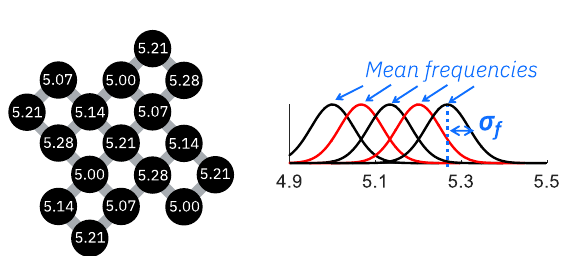
Fig. 6 Frequency collision statistical model. Left: Square lattice, d = 3 with 5-frequency pattern of Fig. 3: f 1 = 5.00, f 2 = 5.07, f 3 = 5.14, f 4 = 5.21, f 5 = 5.28 GHz. To model the lattice statistically, treat the frequencies f 1 to f 5 as means of distributions. Right: Mean frequencies and normal distributions characterized by σ f . For each position in the lattice, sample from the local distribution. Choose random frequencies in this fashion, count collisions as described in Table 1, and repeat to gather statistical sample. Process is repeated for differing spacings between mean frequencies f 1 to f 5 and for different distribution widths σ f